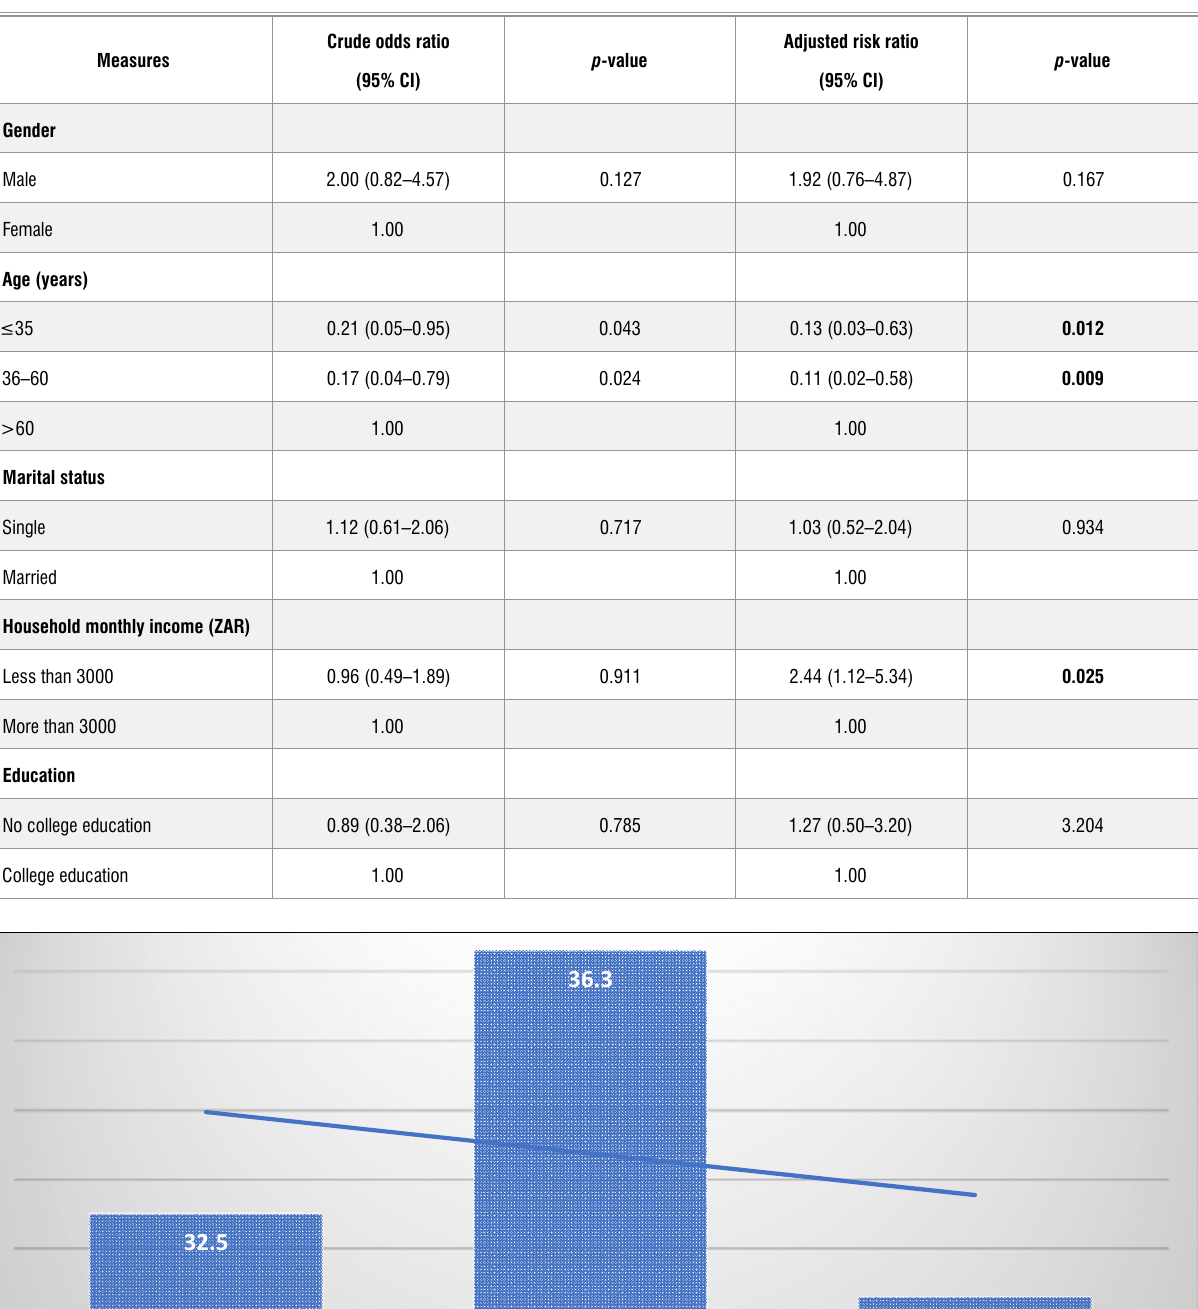
Association between participant’s sociodemographic parameters and dietary diversity score of ≤4 food groups ( n =640)